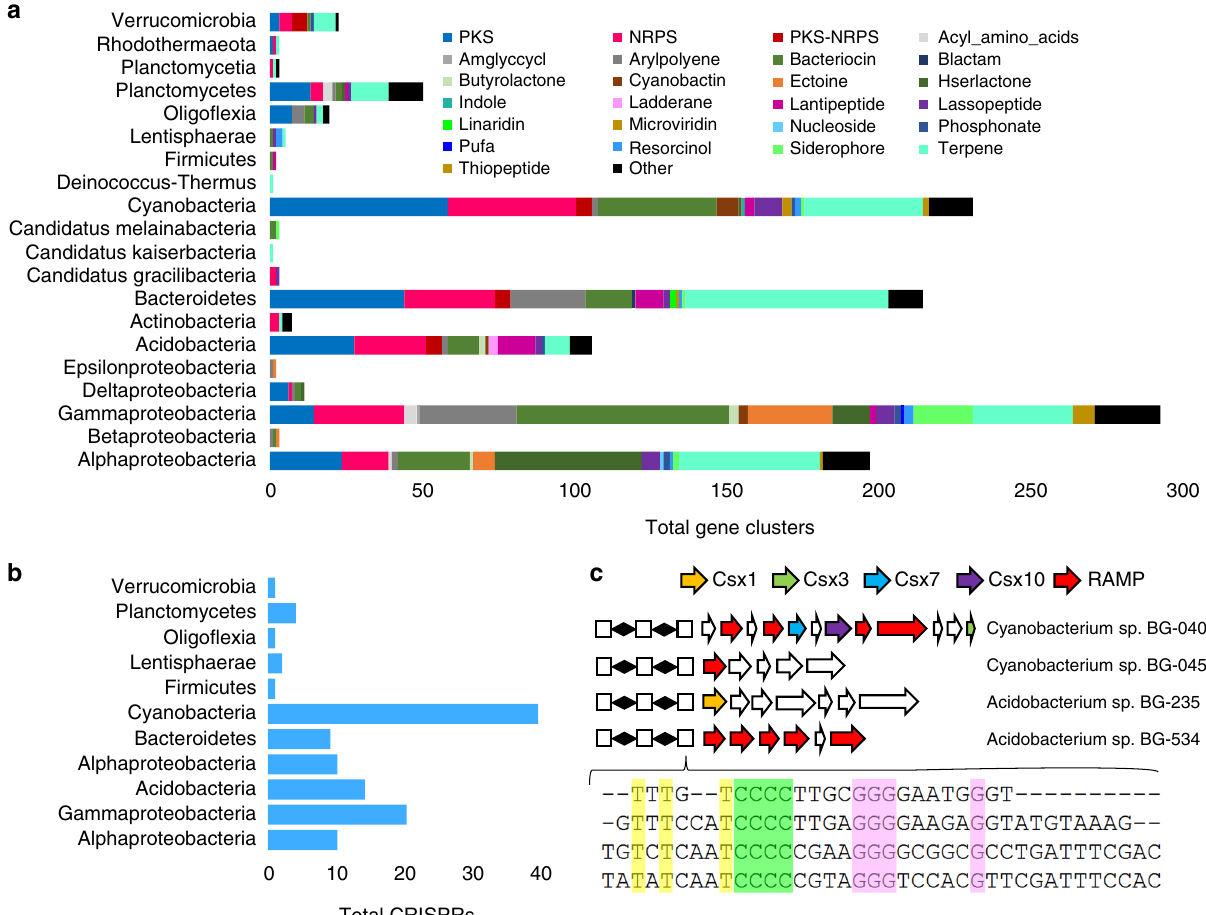
Fig. 6 Functional potential of the bio fi lm-forming microbes as revealed by analysis of 479 microbial genomes. a Biosynthetic gene clusters found on the 479 genomes recovered from 101 bio fi lm metagenomes. Putative product types were assigned by antiSMASH. b Number of CRISPR arrays identi fi ed from bio fi lm-derived genomes. c CRISPR arrays reconstructed from two cyanobacterial genomes and two acidobacterial genomes. White boxes indicate repeats and diamonds indicate spacers. Conserved T, C, and G nucleotides are displayed in yellow, green, and pink, respectively. The putative CRISPR-associated genes are shown with different colors, most of which are RNases. RAMP repeat associated mysterious